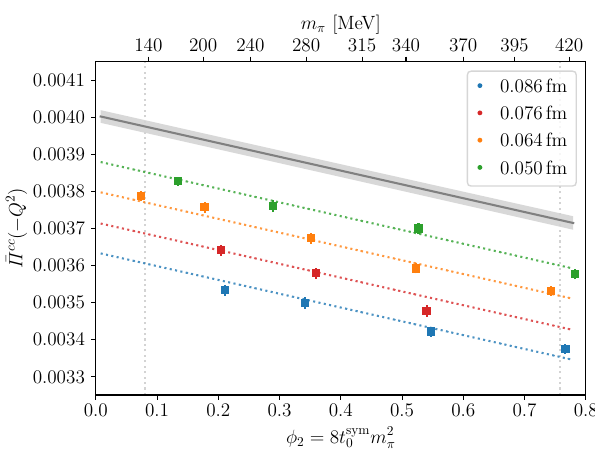
Figure 8 . Same as figure 6 for the charm contribution ¯ Π cc ( − Q 2 ) at Q 2 = 1 GeV 2 . for both ¯ Π 33 and ¯ Π 88 . Including this term in eqs. (4.1), (4.2) and (4.3), we do not